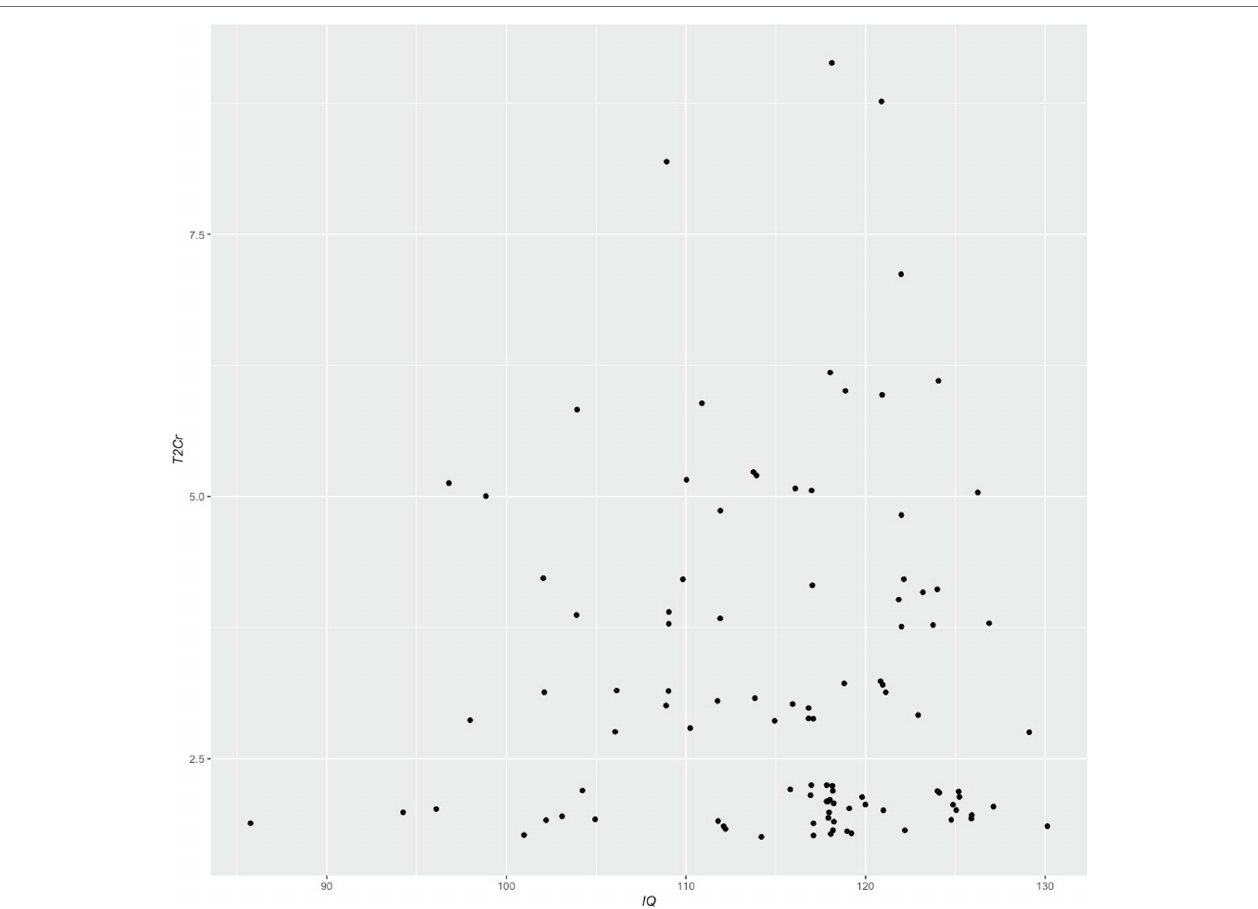
FIGURE 3 | Relationship between Spatial Learning Task scores (T2Cr) and intellect (IQ). Data points have been jittered in x and y to enable visualisation of overlapping data points improve